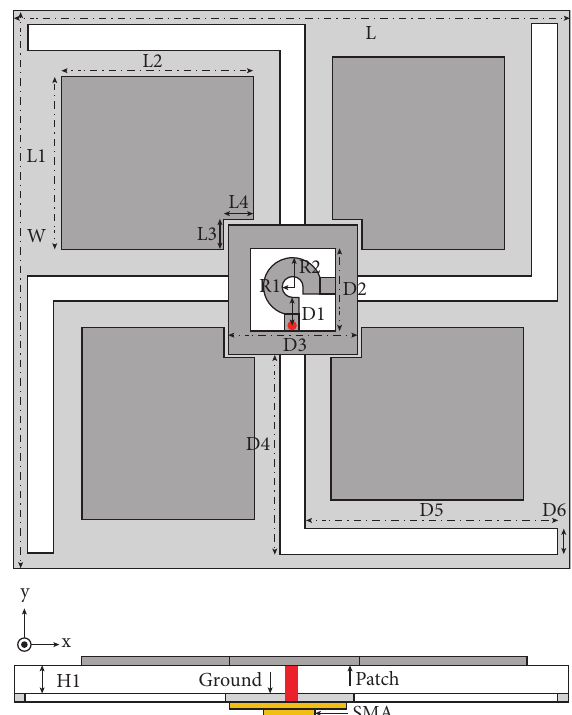
Figure 1: Geometry of the proposed